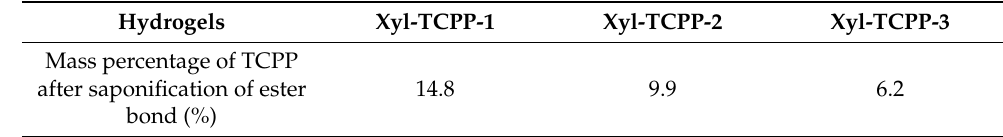
Table 1. Mass percentage of TCPP determined for each hydrogel.